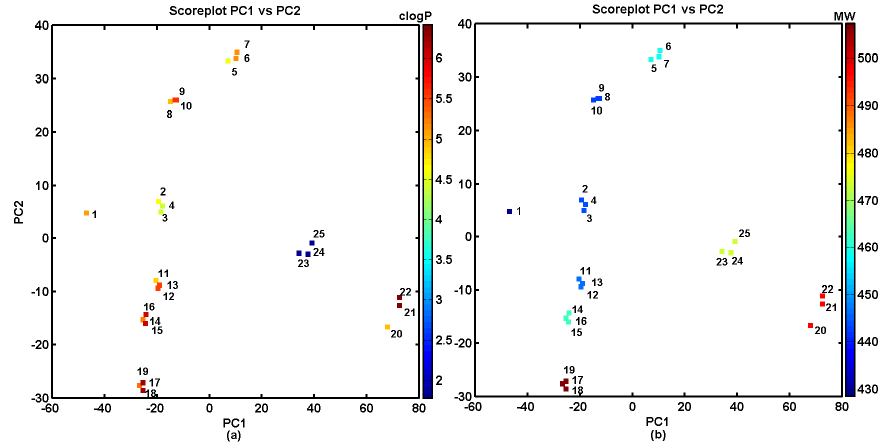
Figure 1. Projection of carbamates 1 – 25 on the plane defined by the first versus second principal components for Dragon descriptors with BChE activity on the logarithmic scale ( a ) and rule of five violations ( b ). Colors indicate the numerical values of pBChE activity and rule of five (Ro5) violations.